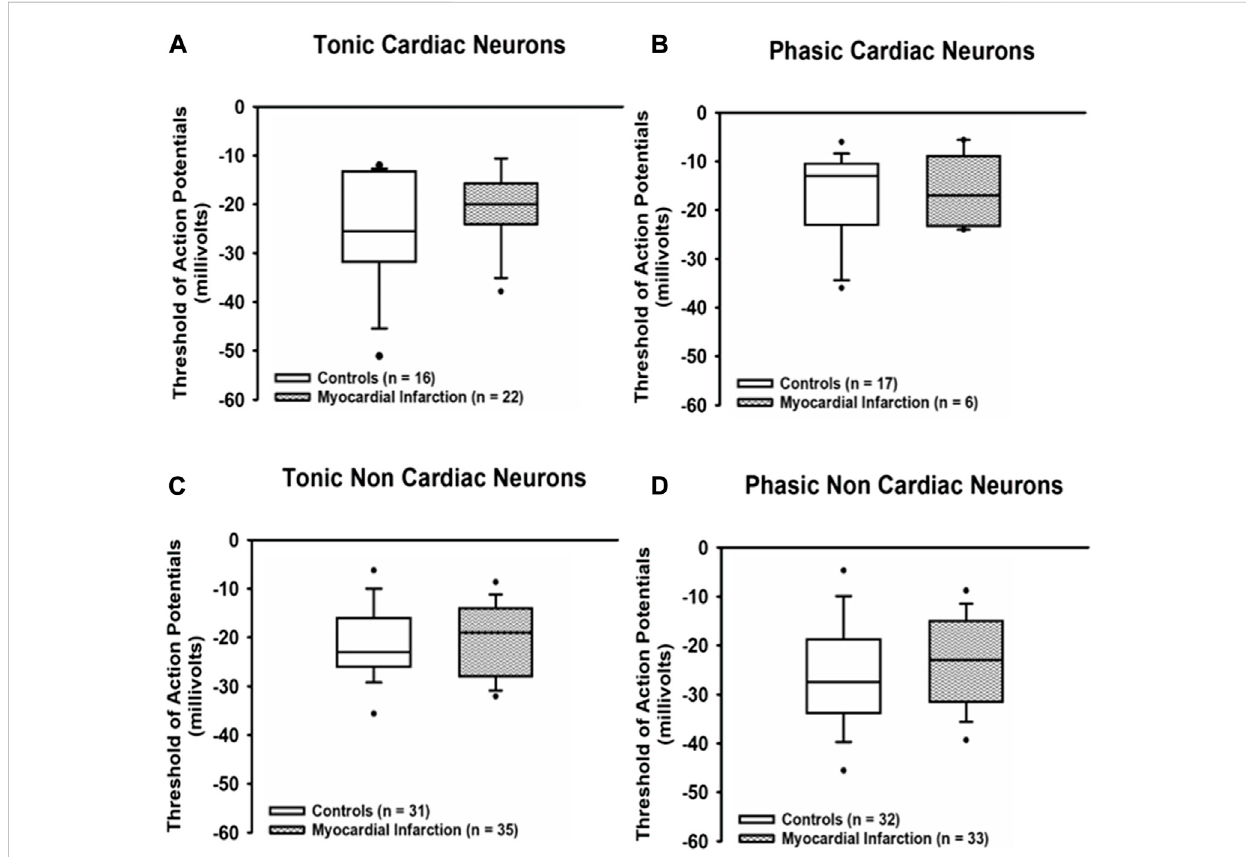
FIGURE 4 Myocardial infarction did not affect threshold potentials. Threshold potentials (mV) of action potentials due to current injection in all groups of neurons [upper panels (A,B) : cardiac; lower panels (C,D) : non-cardiac] were not signi fi cantly different among the various groups of neurons. Shown are the medians, the 25th/75th (box boundaries) and the 10th/90th percentiles (black dots). Kruskal – Wallis one-way ANOVA on ranks was used with Dunn ’ s post - hoc method. Neurons were investigated in the voltage clamp mode of patch clamp